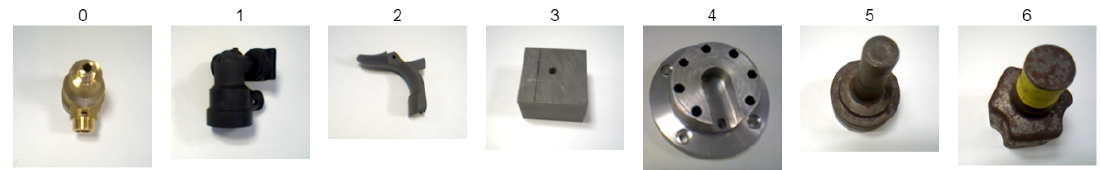
Figure 5. Pictures of the parts used in the experiment.